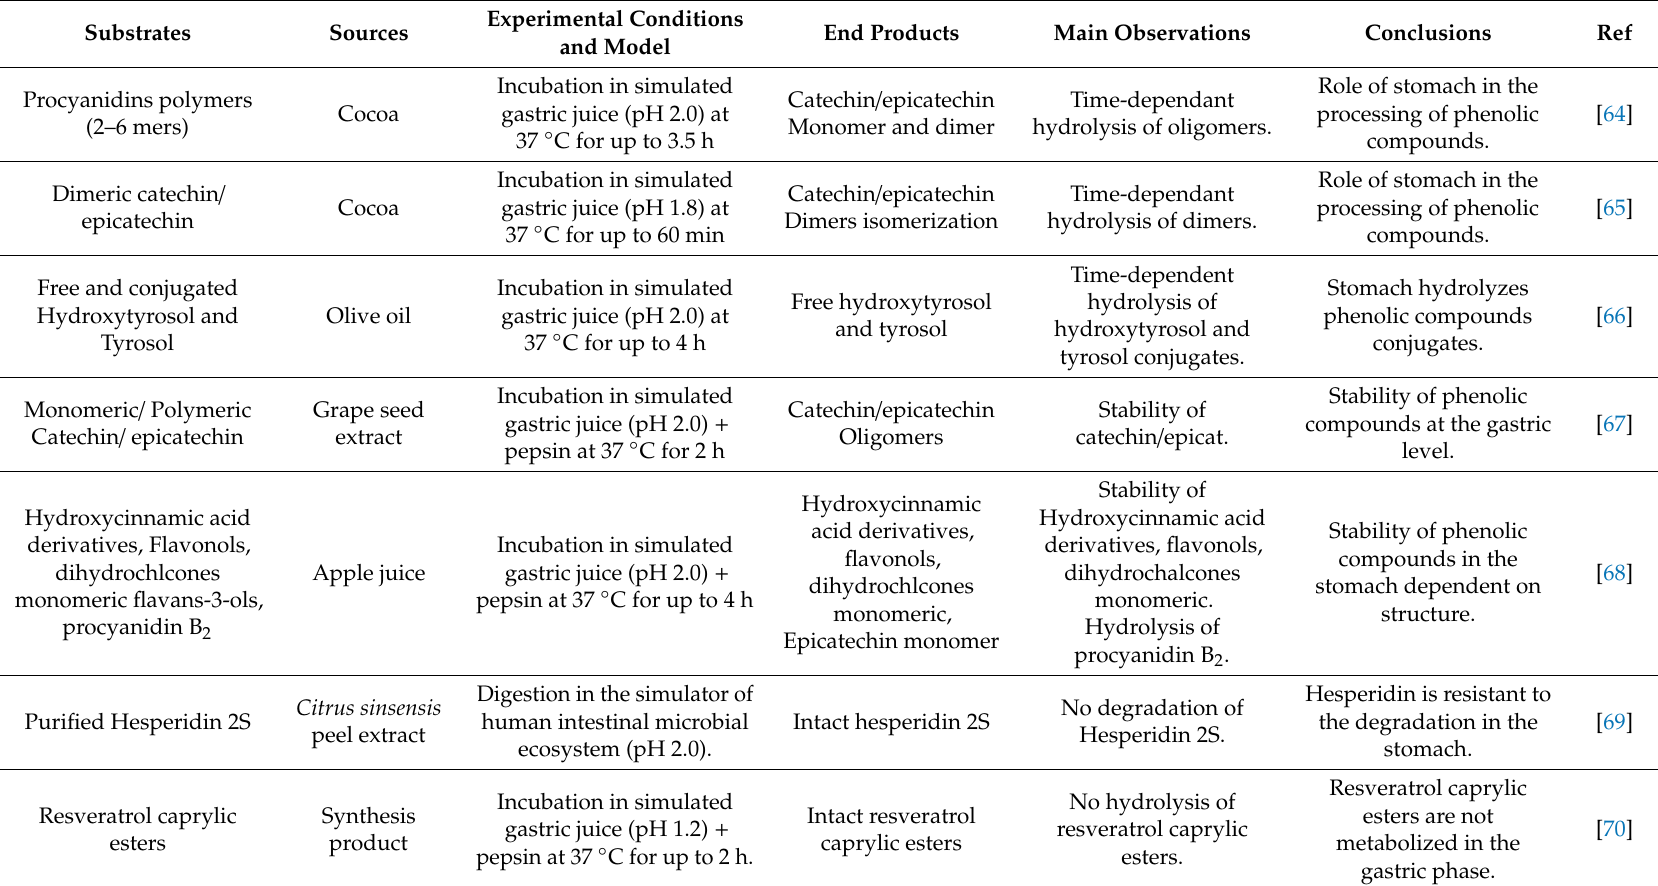
Table 1. Gastric handling of